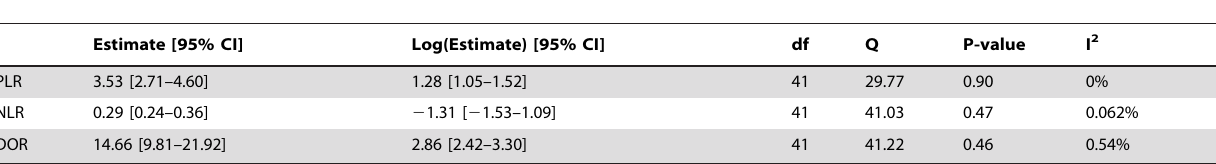
Table 2. The heterogeneity analysis of diagnostic effects.